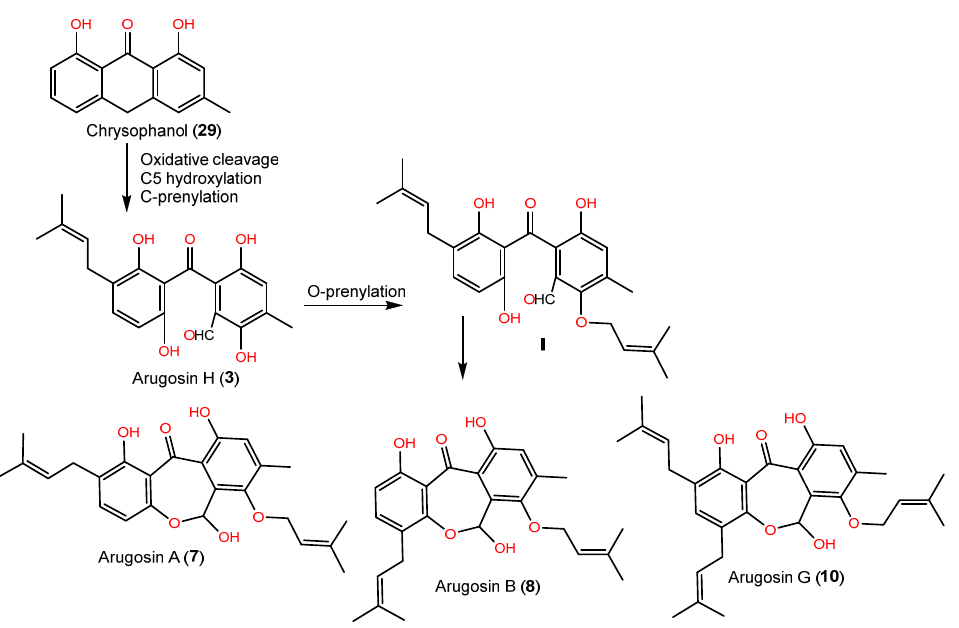
Table 3. Xanthones and quinones reported from Aspergillus nidulans